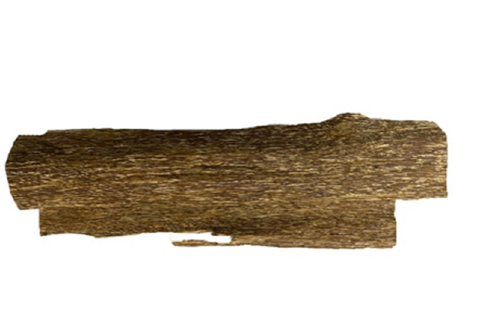
Figure 1. Artificial and wild